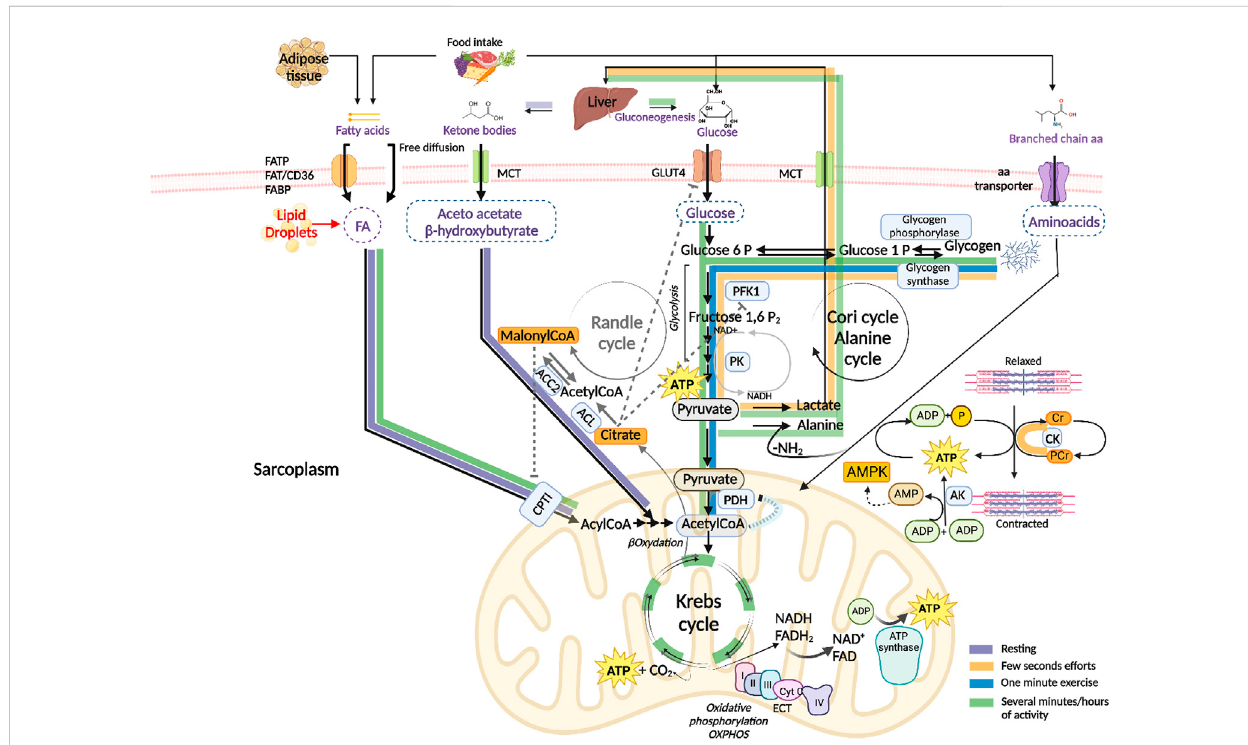
FIGURE 1 Schematic presentation of the energy substrates used by skeletal muscle to produce adenosine triphosphate (ATP) under different conditions. ATP hydrolysis to Adenosine diphosphate (ADP) and phosphate (P), catalyzed by myosin ATPase, provides the energy necessary for skeletal muscle contractionPurplearrows:themainenergysourcesusedbyrestingmusclearefattyacidsfromadiposetissueandketonebodiesfromliver.Afterpassing the sarcolemma, fatty acids enter the mitochondria where they are degraded to acetyl CoA ( β oxidation) and completely oxidized to carbon dioxide in the Krebs cycle which generates ATP and the reduced forms of the nicotinamide adenine dinucleotide (NAD) and fl avin adenine dinucleotide (FAD) cofactors.NADHandFADH 2 oxidationbytheelectrontransportchain(ETC.)iscoupledtoATPsynthesis(oxidativephosphorylation,OXPHOS).Glucoseis used to replenish the glycogen stores by glycogen synthase. Fatty acid – binding protein (FABP), fatty acids transport proteins (FATPs), fatty acids translocase (FAT/CD36), monocarboxylate transporters (MCTs), carnitine palmitoyltransferase I (CPTI). Orange arrows: in the very early seconds of activity,degradationofphosphocreatine(PCr)bycreatinekinase(CK)releasesfreeCrandP,whichistransferredtoADPtoregenerateATP.Theadenylate kinase (AK) enzyme catalyzes the formation of ATP and Adenosine monophosphate (AMP) from two ADP molecules. AMP activates the AMP kinase (AMPK), a key sensor of the energy level the cell. ATP is also generated by anaerobic glycolysis, where glucose-6-phosphate derived from muscle glycogen (by means of glycogen phosphorylase) is catabolized to pyruvate by glycolytic enzymes including phosphofructokinase 1 (PFK1) and pyruvate kinase (PK), which is reduced to lactate. Lactate is released into the circulation and taken up by the liver for the synthesis of glucose through gluconeogenesis (Cori cycle). Blue arrows: when high power exercise lasts beyond one minute, ATP is mainly generated by oxidative metabolism of glycogen-derived glucose. Pyruvate is transported to the mitochondrion and transformed into acetyl CoA by the pyruvate dehydrogenase